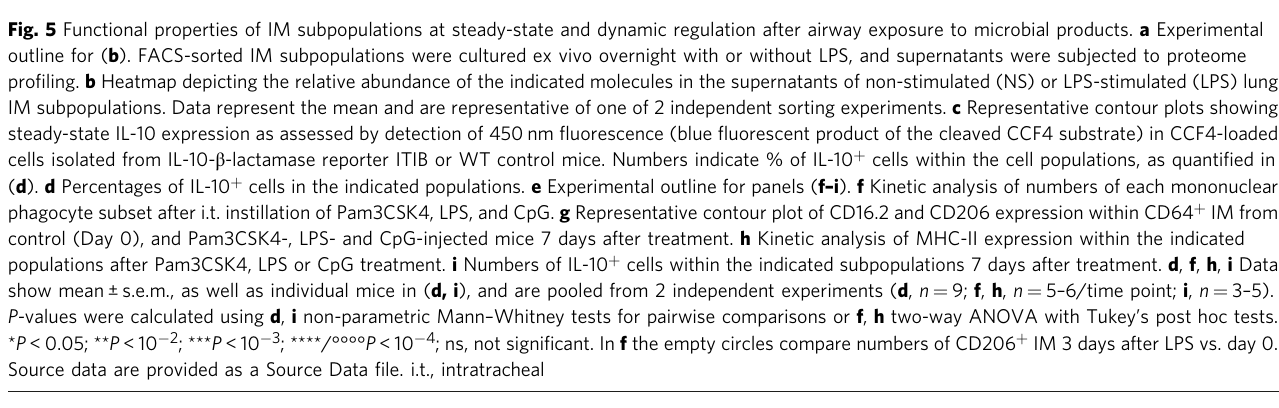
Fig. 5 Functional properties of IM subpopulations at steady-state and dynamic regulation after airway exposure to microbial products. a Experimental outline for ( b ). FACS-sorted IM subpopulations were cultured ex vivo overnight with or without LPS, and supernatants were subjected to proteome pro fi ling. b Heatmap depicting the relative abundance of the indicated molecules in the supernatants of non-stimulated (NS) or LPS-stimulated (LPS) lung IM subpopulations. Data represent the mean and are representative of one of 2 independent sorting experiments. c Representative contour plots showing steady-state IL-10 expression as assessed by detection of 450 nm fl uorescence (blue fl uorescent product of the cleaved CCF4 substrate) in CCF4-loaded cells isolated from IL-10- β -lactamase reporter ITIB or WT control mice. Numbers indicate % of IL-10 + cells within the cell populations, as quanti fi ed in ( d ). d Percentages of IL-10 + cells in the indicated populations. e Experimental outline for panels ( f – i ). f Kinetic analysis of numbers of each mononuclear phagocyte subset after i.t. instillation of Pam3CSK4, LPS, and CpG. g Representative contour plot of CD16.2 and CD206 expression within CD64 + IM from control (Day 0), and Pam3CSK4-, LPS- and CpG-injected mice 7 days after treatment. h Kinetic analysis of MHC-II expression within the indicated populations after Pam3CSK4, LPS or CpG treatment. i Numbers of IL-10 + cells within the indicated subpopulations 7 days after treatment. d , f , h , i Data show mean ± s.e.m., as well as individual mice in ( d, i ), and are pooled from 2 independent experiments ( d , n = 9; f , h , n = 5 – 6/time point; i , n = 3 – 5). P- values were calculated using d , i non-parametric Mann – Whitney tests for pairwise comparisons or f , h two-way ANOVA with Tukey ’ s post hoc tests. * P < 0.05; ** P < 10 − 2 ; *** P < 10 − 3 ; ****/°°°° P < 10 − 4 ; ns, not signi fi cant. In f the empty circles compare numbers of CD206 + IM 3 days after LPS vs. day 0. Source data are provided as a Source Data fi le. i.t.,